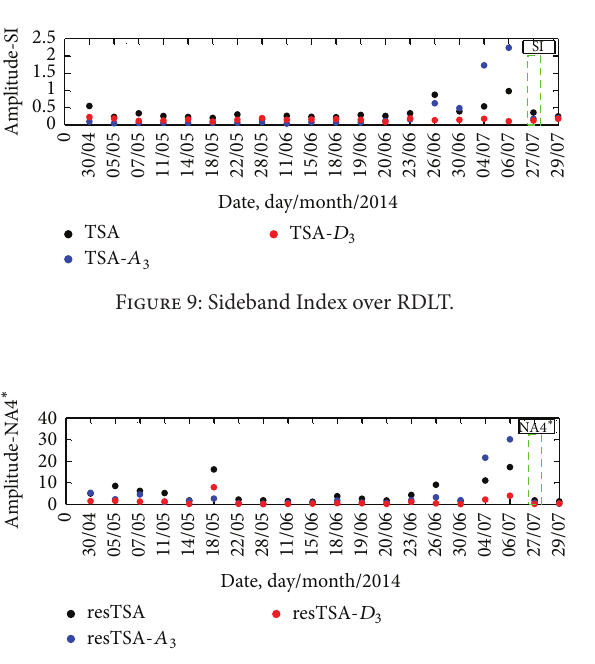
Figure 12: M8A over